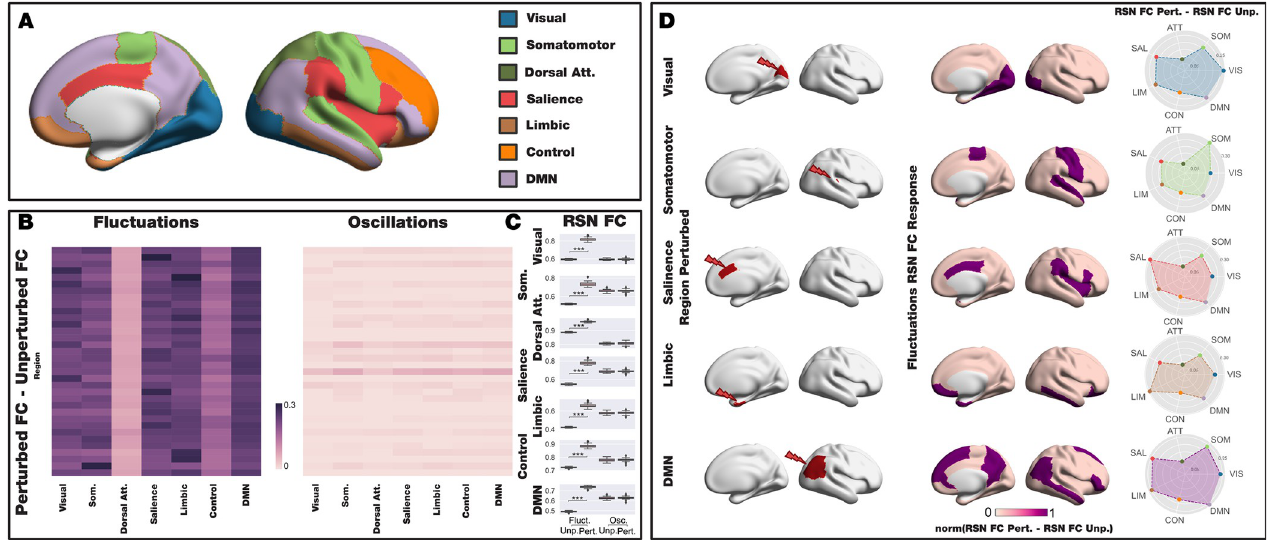
Fig 7. Revealing the causal mechanistic principles of empirical results modulating resting state networks using stimulation. A) For the reference, the seven Yeo resting state networks are rendered in the medial and lateral surface of the right hemisphere of the brain. B) Local and Sustained stimulation differentially enhances the resting state networks. The difference in the level of FC between the perturbed and unperturbed case is shown for the seven Yeo resting state networks as a function of the perturbed node. The subcritical regime enhances the FC for all networks and nodes, while the supercritical regime is much smaller and almost constant across nodes and networks. C) The seven subpanels show boxplots of the mean FC on each one of the seven Yeo resting state networks of the two model regimes in the unperturbed and perturbed case. The subcritical regime shows higher levels for the 7 networks and while the supercritical case remains almost unaltered with the perturbation. The significance of the results was assessed using the Wilcoxon rank-sum test , where ��� represents p < 0 . 001 . D) Left column shows a representative region (in red) in different resting state networks being perturbed in the fluctuating regime, which gives rise to a stabilisation of the respective network. The middle column is showing a rendering of the normalised difference between the perturbed and unperturbed activity in terms of RSN FC, thresholded to top 15%. The difference between the perturbed and unperturbed RSN FC can be seen in the spiderplots (right column), where the elicited activity is maximal for the stimulated network.